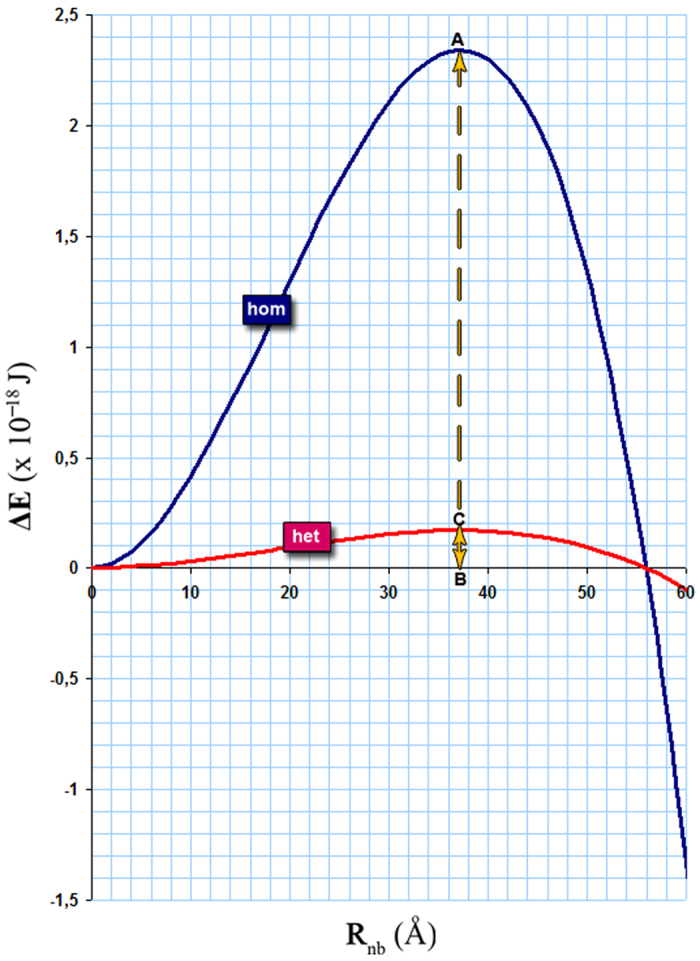
Free energies values for the formation of a nanobubble and an interfacial nanobubble of radius Rnb in CH2Br2 under negative pressure;AB = ΔΕhom = 2.34 × 10−18J and CB = ΔΕhet = 1.56 × 10−19 J. Heterogeneous nucleation requires about the 1/15th of homogeneous nucleation energy to form an INB of Rnb = 37 Å with lateral size α/2 = Rnb sin(π−133o) = 27 Å.